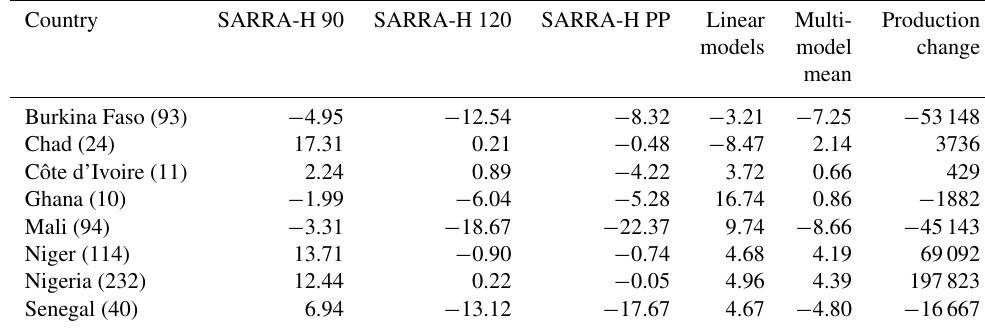
Table 7. Percentage millet yield change by country. The number of grid cell analysed is in brackets and countries where fewer than 10 grid cells were analysed have been omitted. The production change is shown in the rightmost column in tonnes.